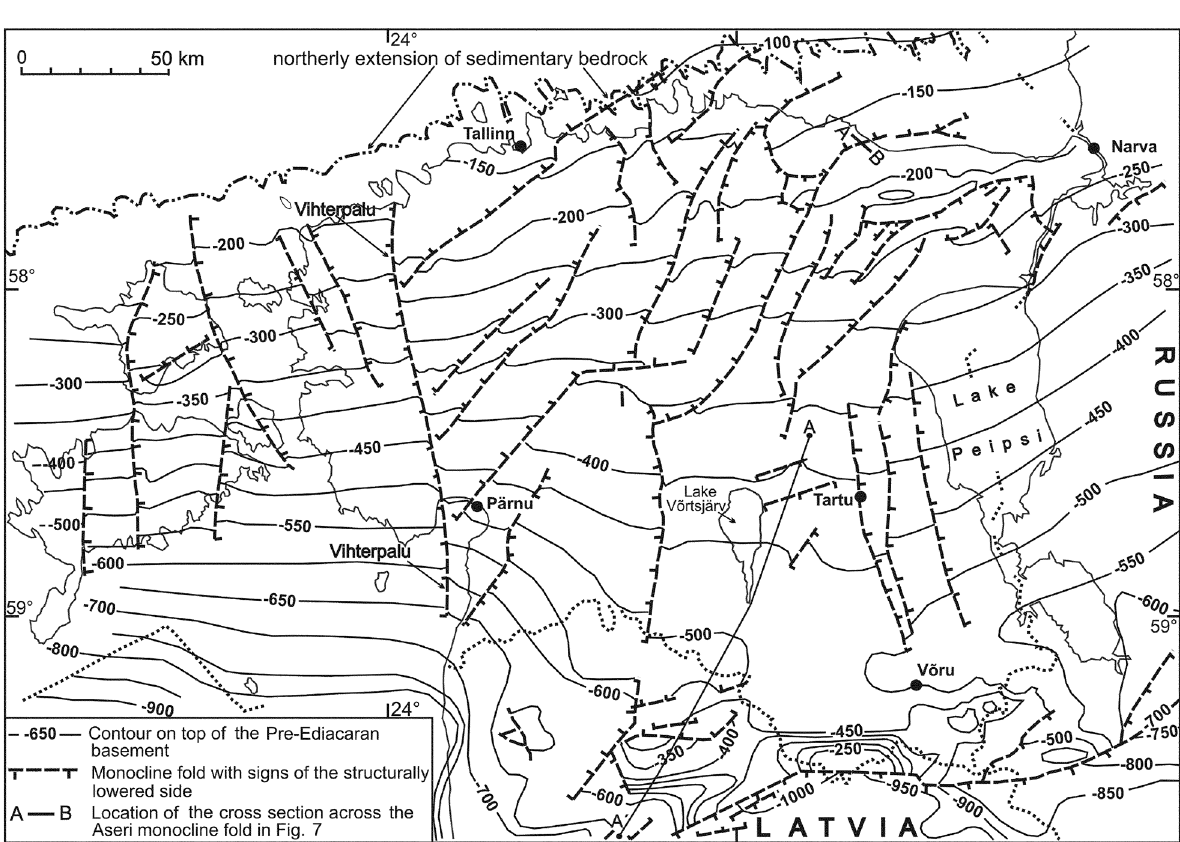
Fig. 6. Structure contour map on top of the cratonic basement of the Estonian Homocline with platform monocline folds (modified after Puura & Vaher 1997). A–A´ – location of the cross section in Fig. 8.